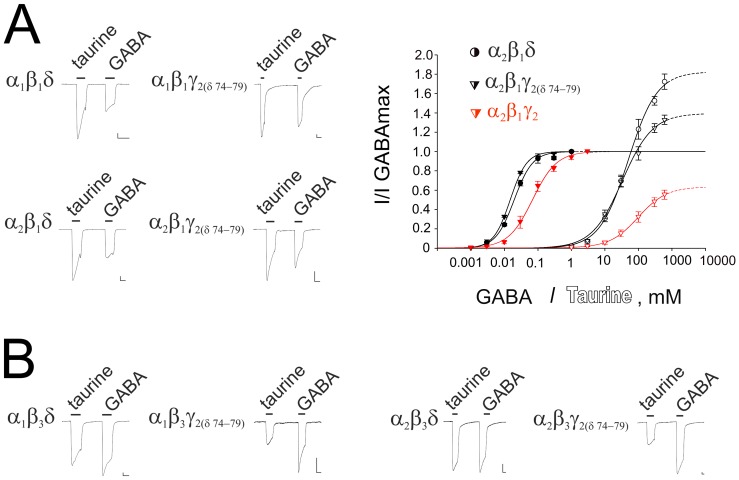
Chimeric αxβ1γ2(δ74–79) receptors show superagonistic properties of taurine.(A and B) Representative current traces (comparison of taurine (600 mM) - and GABA (0.3–3 mM) - evoked maximal currents) are shown for different receptor types. (A) Concentration - response curves for the β1 -containing receptors. Concentrations of agonist are plotted versus current amplitudes normalized on maximal GABA response (filled symbols for GABA -, open symbols for taurine - responses). Red curves are given for comparison with γ2 (WT) - containing receptors. Note the dramatic increase in taurine efficacy over GABA in chimeric β1 - containing GABAAR, which renders them similarity with the α2β1δ receptors.